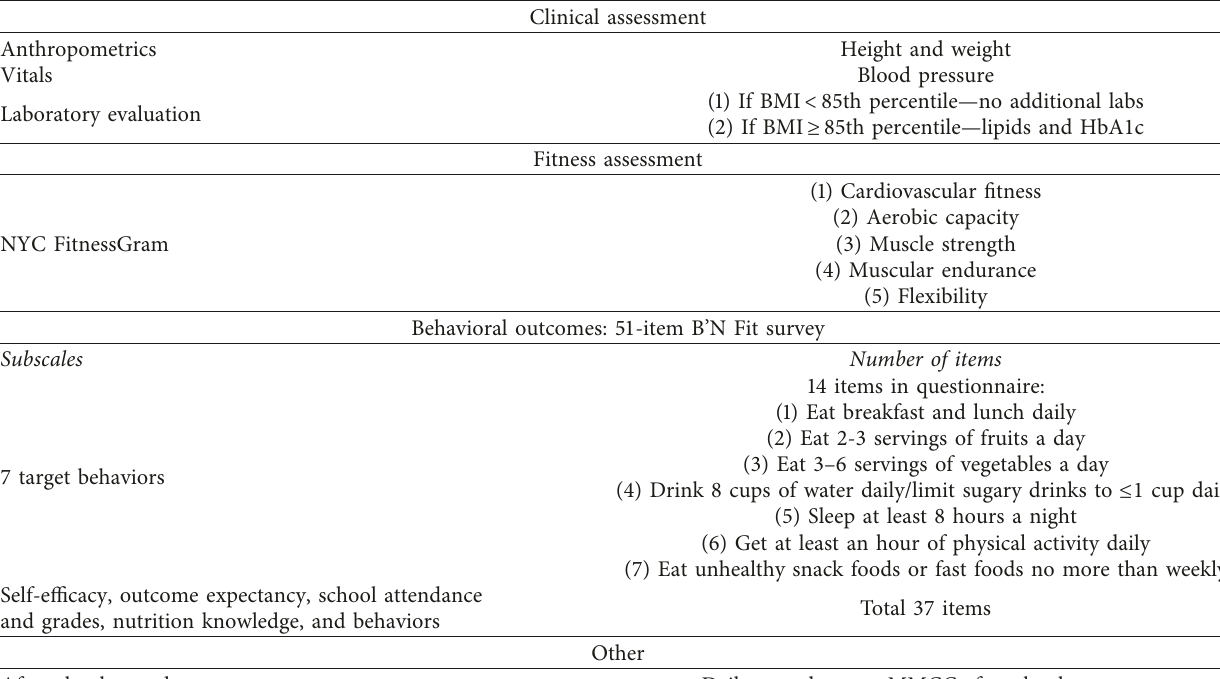
Table 2: Intervention outcome